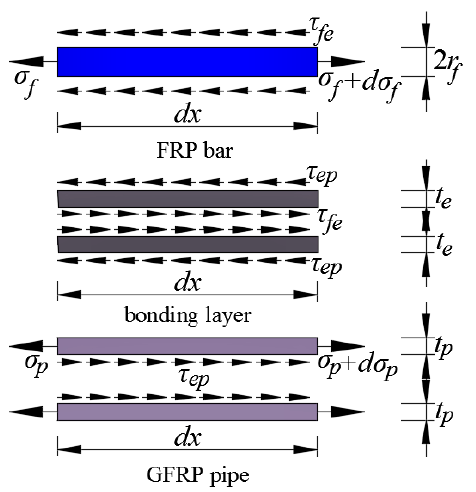
Figure 4. Mechanical analysis of the differential element.